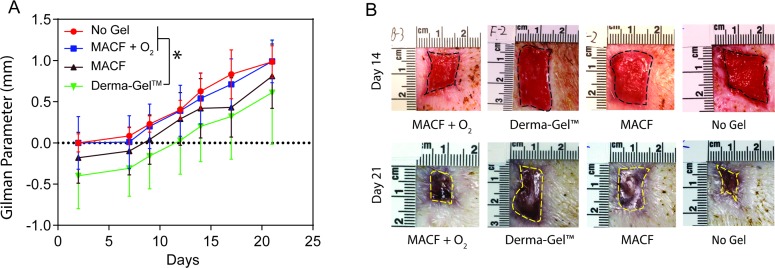
Wound closure shows significant benefits of hydrogel treatment over comparison dressing.A) Gilman parameter analysis. Letters denotes significance by GLM for ANOVA at each time point used as a repeated measure, (p < 0.05). Mean+/-SD, n = 3 (pigs), s = 4 (wounds/region) wounds for all groups. B) Wound pictures at Day 14 and Day 21.